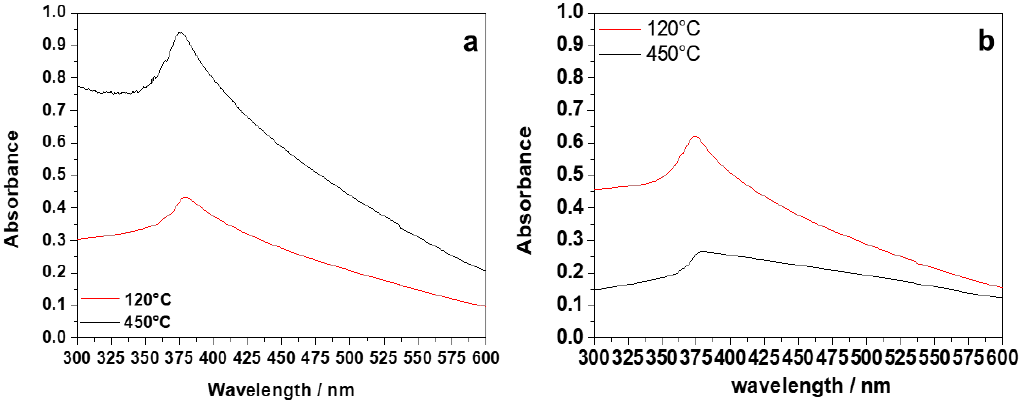
Figure 4. UV–Vis spectra of dried (120 °C) and calcined (450 °C) samples: ( a ) ZnO-BAC; ( b ) ZnO-